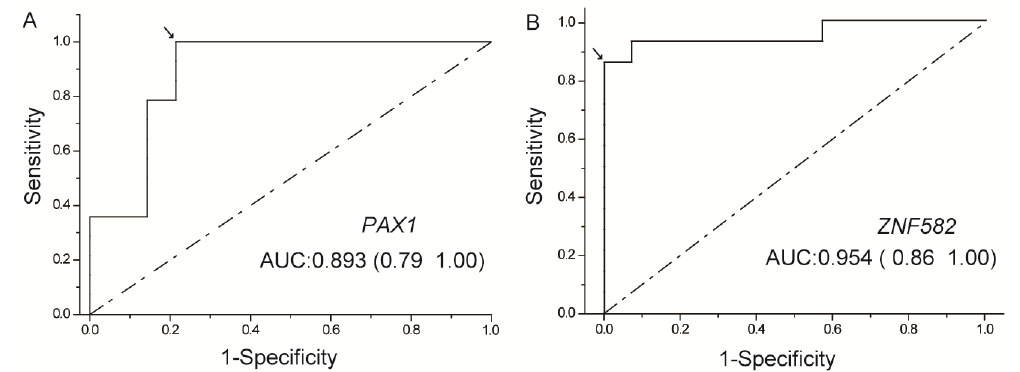
Figure 2. Receiver operating characteristic (ROC) curve analysis of PAX1 ( A ) and ZNF582 ( B ). The area under the ROC curve (AUC) of each gene was calculated for the diagnosis of ESCC tumors. The arrow indicates the best sensitivity and